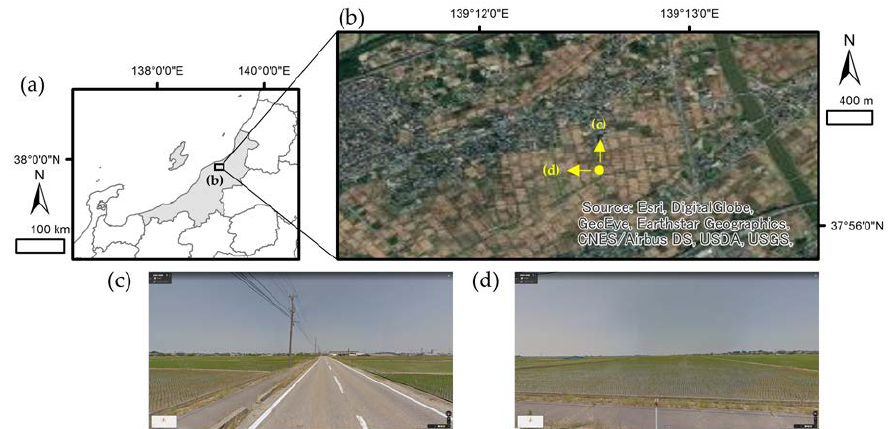
Figure 3. Example of a Google Maps Street View of a “Paddy” reference field in Niigata prefecture. ( a ) and ( b ) indicate the location of reference paddy fields. Yellow arrows show the view angles of the photographs in ( c ) and ( d ) taken from the position indicated by the yellow circle.